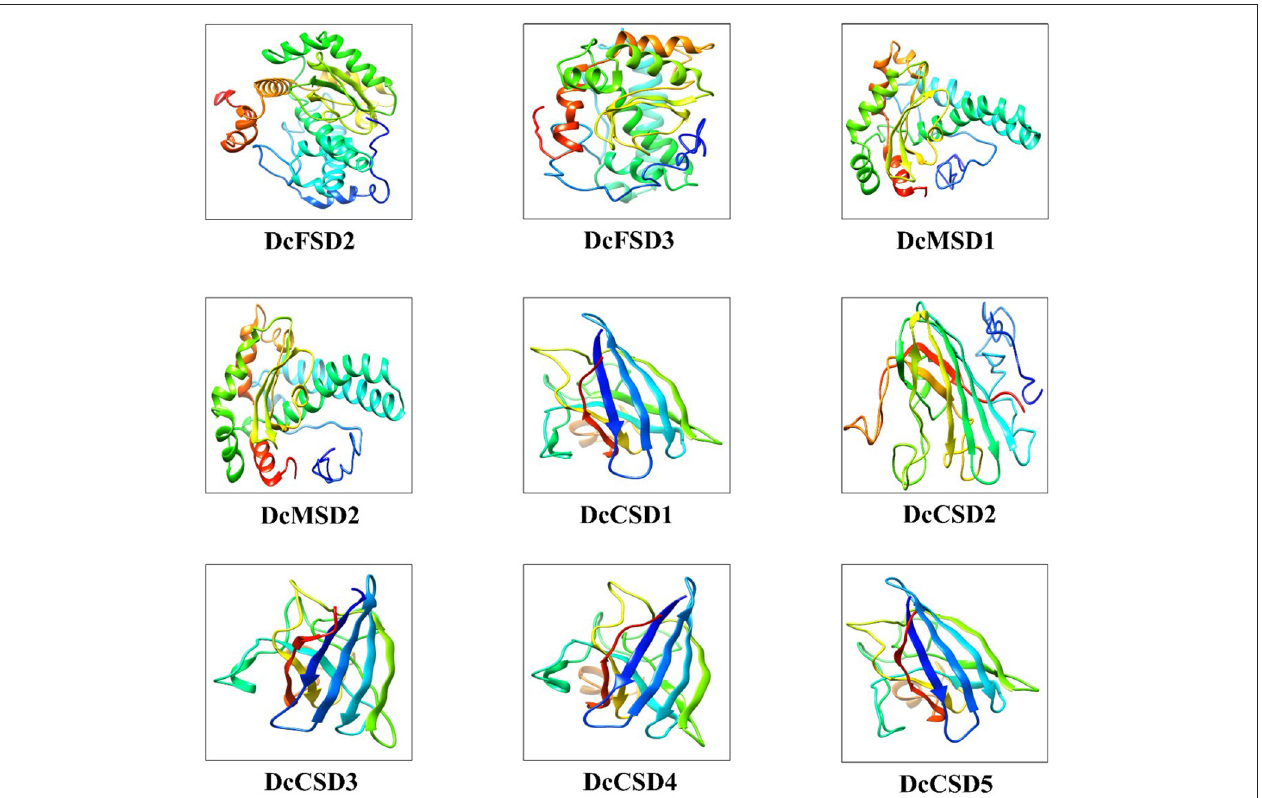
FIGURE 6 | The 3D structure modeling of DcSOD proteins. These are the final models predicted with different colors indicating different helices, sheets, and domains.